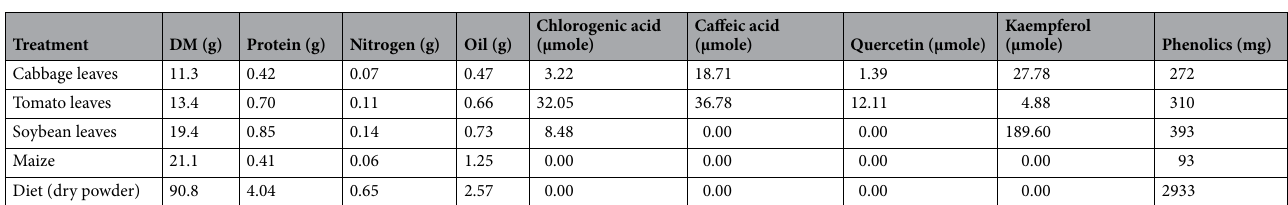
Table 5. Nutritional value analysis of different rearing media based on 100 g edible portion on fresh weight. ( DM dry matter). Luteolin, apigenin, isohamnetin, hesperetin were not found in the processed samples.